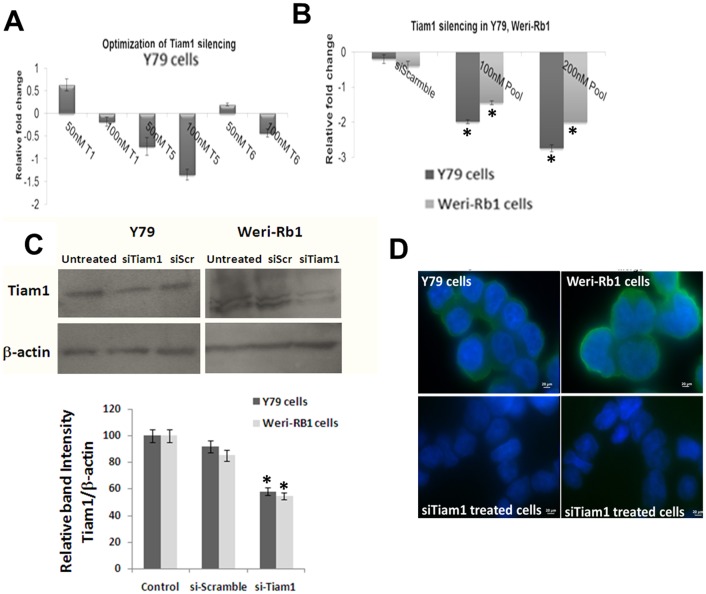
Knockdown of Tiam1 in Y79 and Weri-Rb1 cell lines using RNA interference.
A. Tiam1 silencing in Y79 cells using three siRNA sequences (T1, T5 & T6) targeting different regions of the mRNA at 50 nM and 100 nM concentrations. B. Down-regulation of Tiam1 in Y79 and Weri-Rb1 cells compared to scrambled siRNA mediated by transfection of 100 nM and 200 nM of pooled siRNA. The statistical analysis was calculated using students unpaired t-test and p<0.05 is indicated as asterisk. C. Western blot analysis of Tiam1 post silencing in Y79 and Weri-Rb1 cell lines. β-actin showing a band at 42 KDa is used to normalize within sample and between siRNA transfected and untransfected cells, on the right is the densitometry analysis of western blot showing the relative band intensity of Tiam1 expression of siRNA transfected cells compared to scrambled siRNA transfected cells. The statistical analysis was calculated using students unpaired t-test and p<0.05 is indicated as asterisk. D. Immunofluorescence images of Tiam1 silenced Y79 and Weri-Rb1 cells showing the reduction of Tiam1 expression on plasma membrane compared to untransfected cells showing high level of Tiam1 expression on plasma membrane. The images were taken at ten fields under 100X oil immersion objective. Scale bar: 20 μm. Tiam1 is shown as green and nucleus counterstained with DAPI fluoresces blue in color.